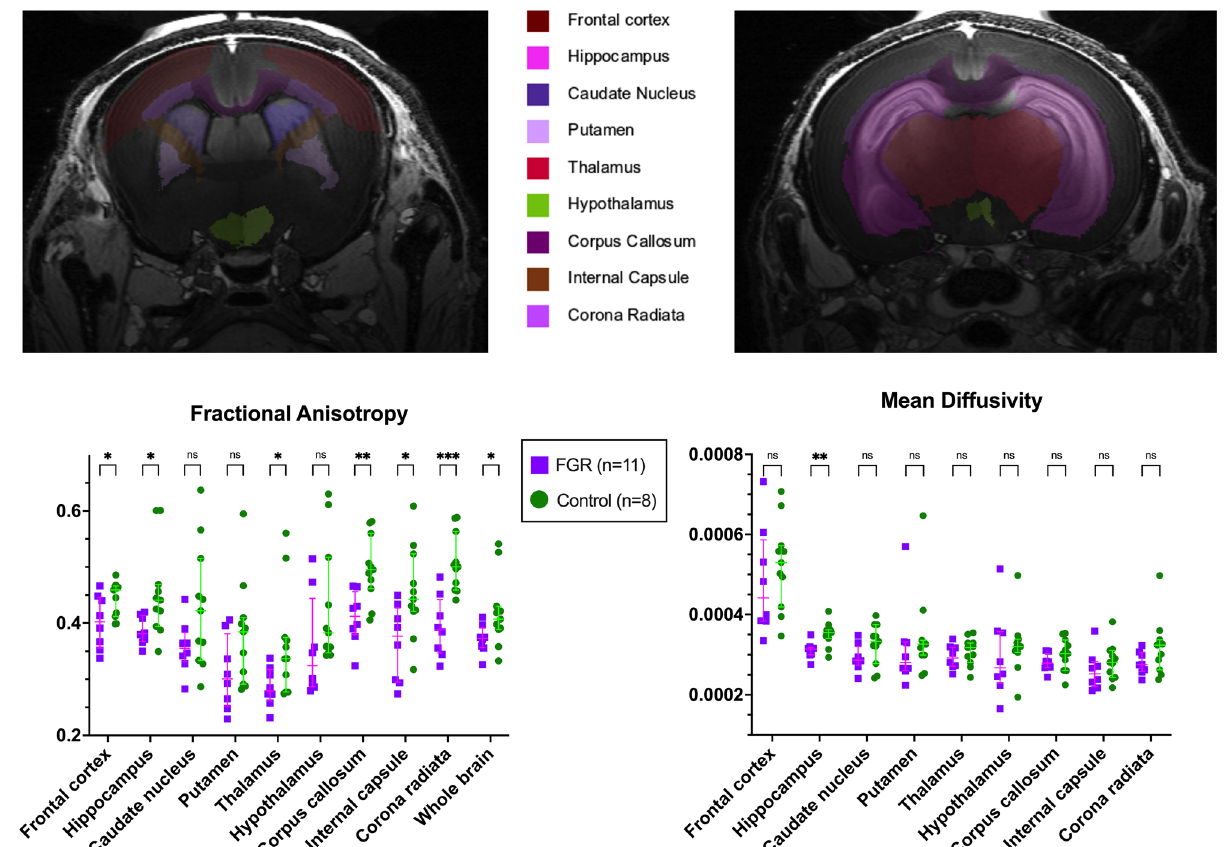
Figure 3. Ex vivo brain diffusion tensor metrics at postnatal day 1 from 11 FGR and 8 control brains, from 6 litters. Data were analysed using a linear mixed-effects model and displayed as mean ± SD with significance as *0.05 ≥ p > 0.01; **0.01 ≥ p > 0.001.; ***0.001 > p > 0.0001; ****p <